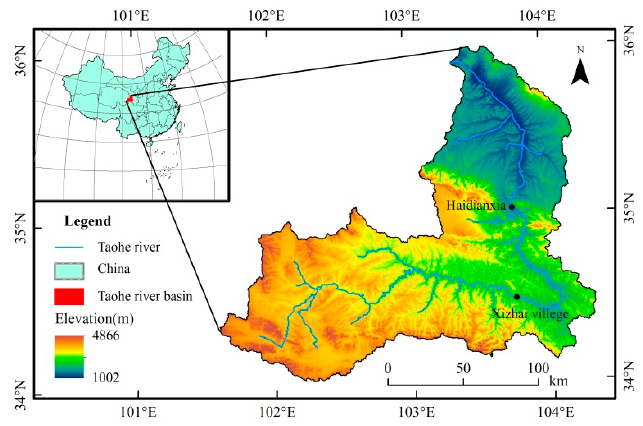
Figure 1. Location of the study area.